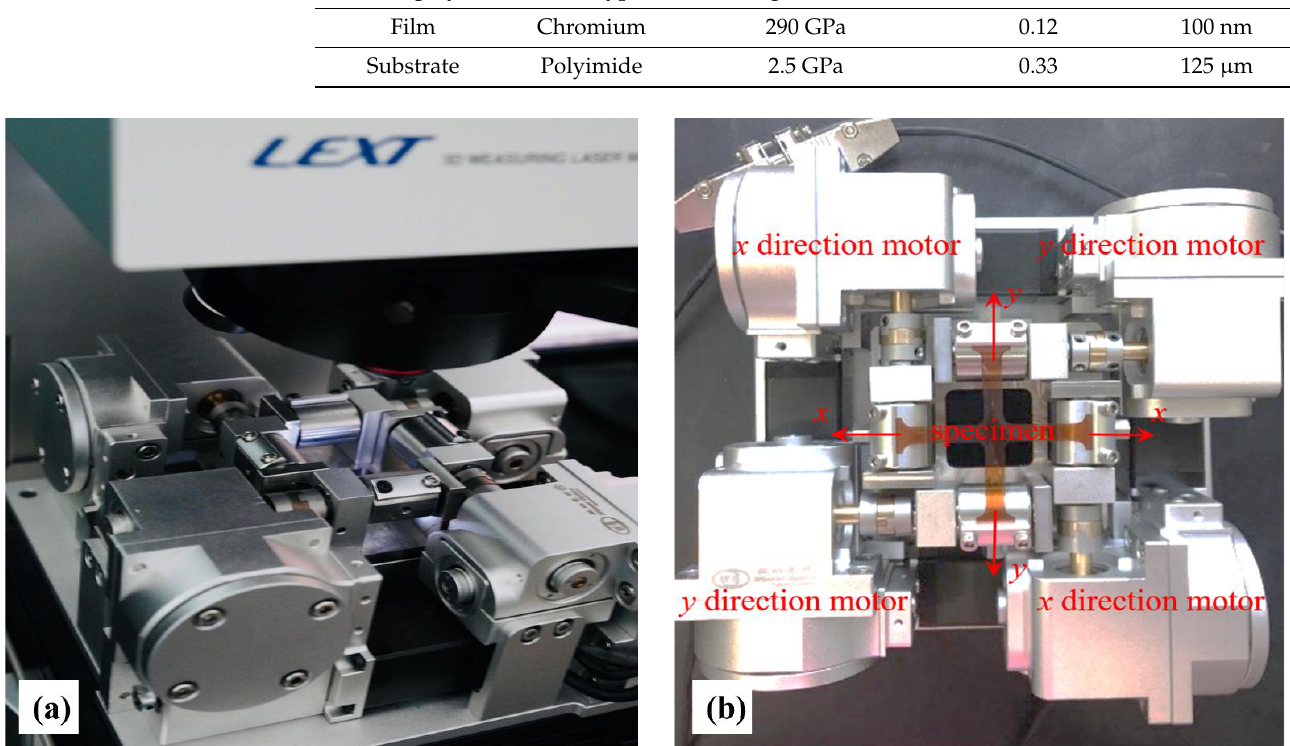
Figure 8. Experimental setup: ( a ) overall setup; ( b ) the top view of the biaxial loading